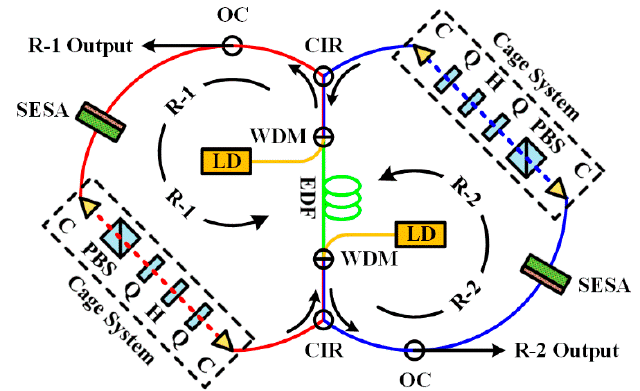
Figure 1. The experimental setup of the multidimensional multiplexing mode-locked laser. EDF, erbium-doped fiber; WDM, wavelength-division multiplexer; CIR, circulator; LD, laser diode; OC, optical coupler; SESA, semiconductor saturable absorber; C, collimator; PBS, polarizing beam splitter; H, half-wave plate; Q, quarter-wave plate; R-1, sub-ring 1 and R-2, sub-ring 2.